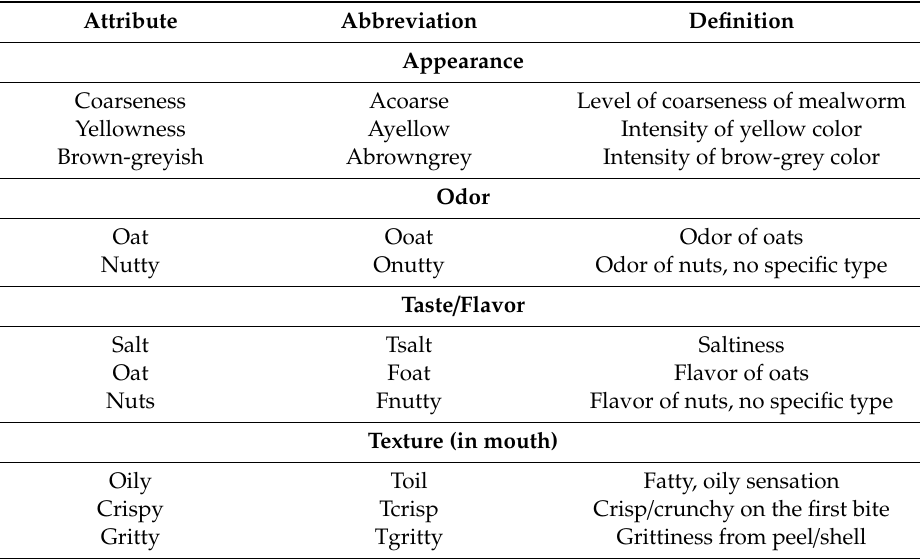
Table 4. Sensory attributes and their